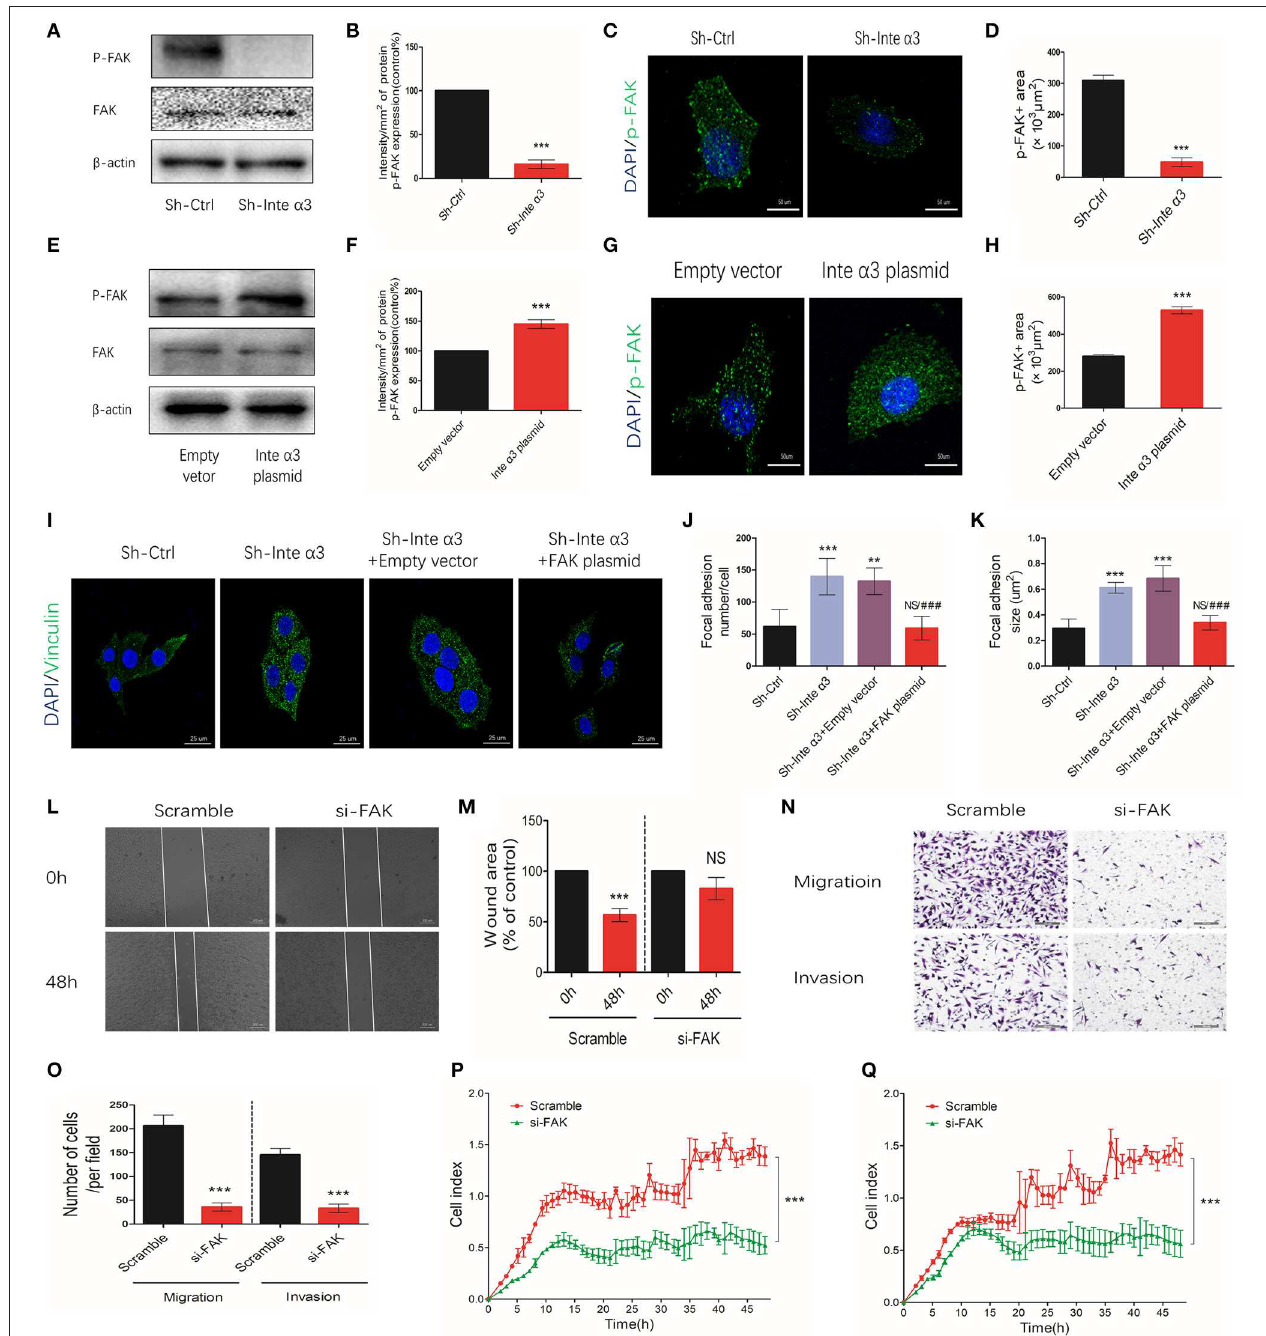
FIGURE 4 | Integrin α 3 impairs focal adhesion formation by activating focal adhesion kinase (FAK). (A,B) Western blotting results of phosphor-Y397-FAK (p-FAK) after knocking down the expression of integrin α 3 using shRNA in vitro and quantification of the intensity of p-FAK protein. (C,D) After knocking down integrin α 3, immunofluorescence was applied to detect the expression levels of p-FAK and quantification of the p-FAK-positive area. (E,F) Western blotting results of p-FAK after overexpressing of integrin α 3 and quantification of the intensity of p-FAK protein. (G,H) Immunofluorescence results of p-FAK after overexpressing integrin α 3 and quantification of the p-FAK-positive area. (I) Focal adhesion formation was investigated through vinculin immunofluorescence in the following four groups: Sh-Ctrl, Sh-Inte α 3, Sh-Inte α + empty vector, and Sh-Inte α 3 + FAK plasmid. (J,K) Quantification of focal adhesion (number and size) in (I) . (L) The wound healing assay was applied to explore the migration of cervical cancer cells in Scramble and si-FAK groups, and the quantification is presented in (M) . (N) Transwell migration and invasion assays were performed in the two groups. (O) Quantification of migration and invasion (cell number) per field. (P,Q) Results related to cell migration and invasion using real-time migration/invasion monitoring. All experiments were repeated thrice with consistent results, and the representative images are shown. ** P < 0.01; *** P < 0.001; ### P < 0.001 vs. Sh-Inte α 3 + empty vector.